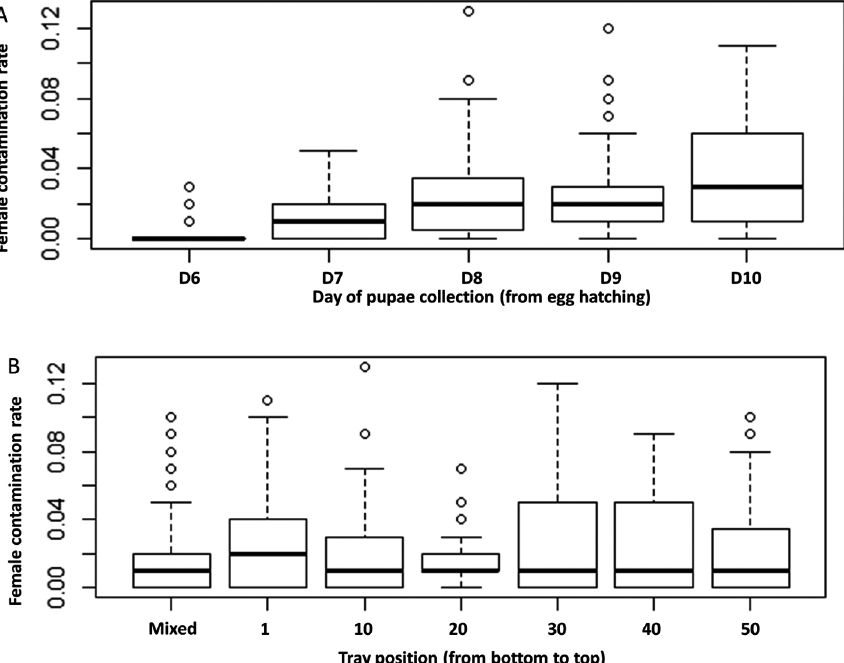
Figure 5. Female contamination rate as (A) a function of the day of pupae collection and (B) the position of the rearing tray inside the rack in Aedes aegypti. Signi fi cantly increased female contamination rate over the course of sorting days. Data presented in the fi gure are expressed as mean ± SE.